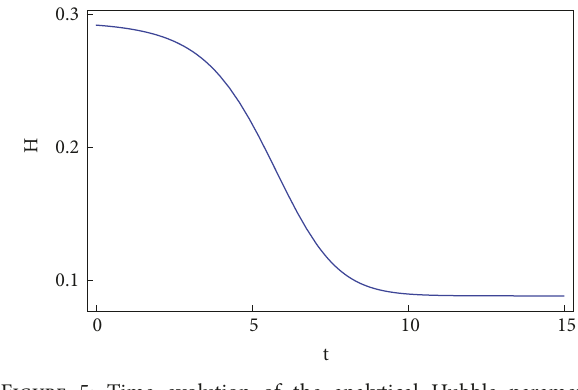
Figure 5: Time evolution of the analytical Hubble parameter derived from our two-field model. Thereis a small step close to 𝑡 = 0 indicating a primordial expansion era which smoothly evolves to another expansion era for later values of